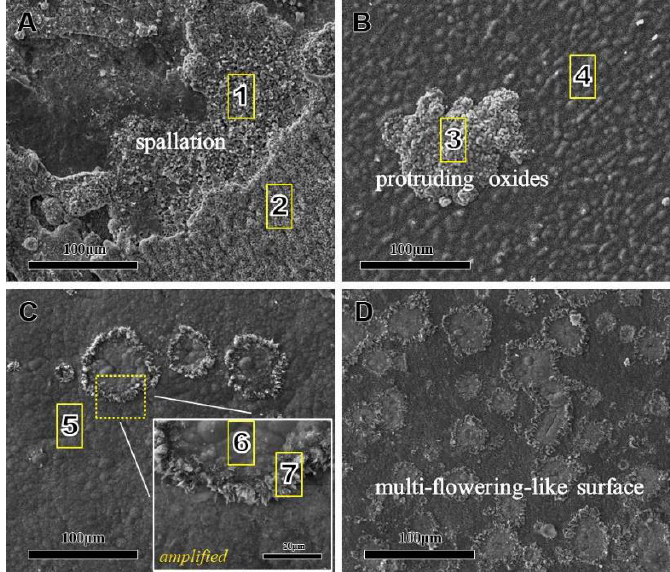
Figure 3. ( A ) X-ray diffraction (XRD) and ( B ) GI-XRD patterns of K38 substrate, SN-K38 and SN-N5 coatings after oxidation at 1050 °C for 100 h (a. γ/γ′, b. α-Al 2 O 3 , c. Cr 2 O 3 , d. TiO 2 , e. θ-Al 2 O 3 ).